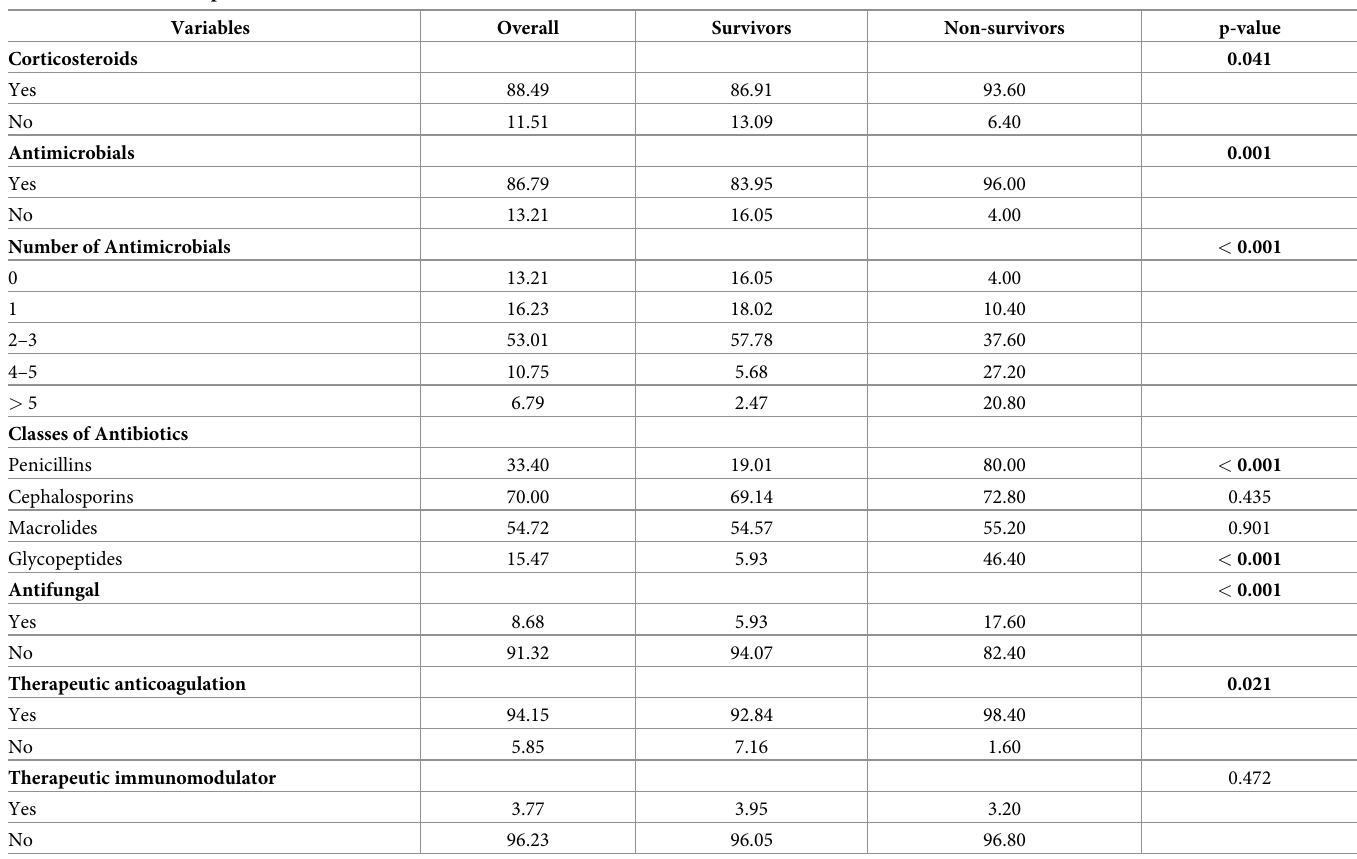
Table 2. Pharmacotherapeutic classes used in the treatment of COVID-19 infection.